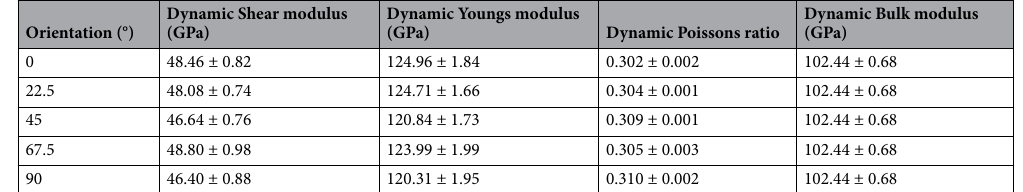
Table 1. Orientation dependent dynamic elastic moduli of LPBF-AM Ti6Al4V.